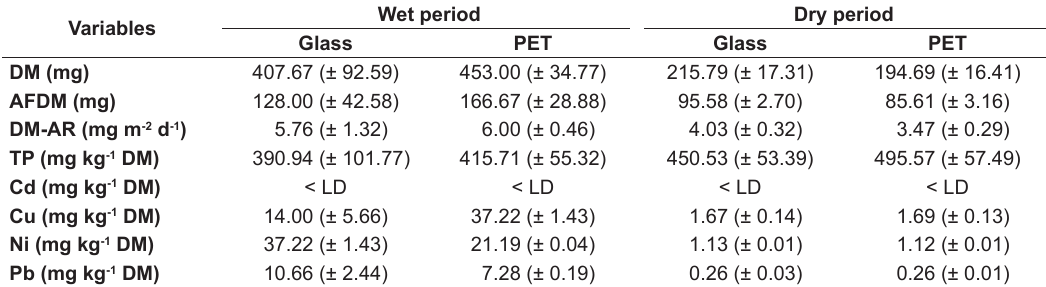
Table 3. Average and standard deviation (n = 3) of dry mass (DM), ash free dry mass (AFDM), dry mass accumulation rate (DM-AR), total phosphorus and metal concentrations in the periphyton on glass and PET slides in wet and dry periods in a eutrophic reservoir. Limit of detection (LD) to Cd was 0.03 mg L -1 .